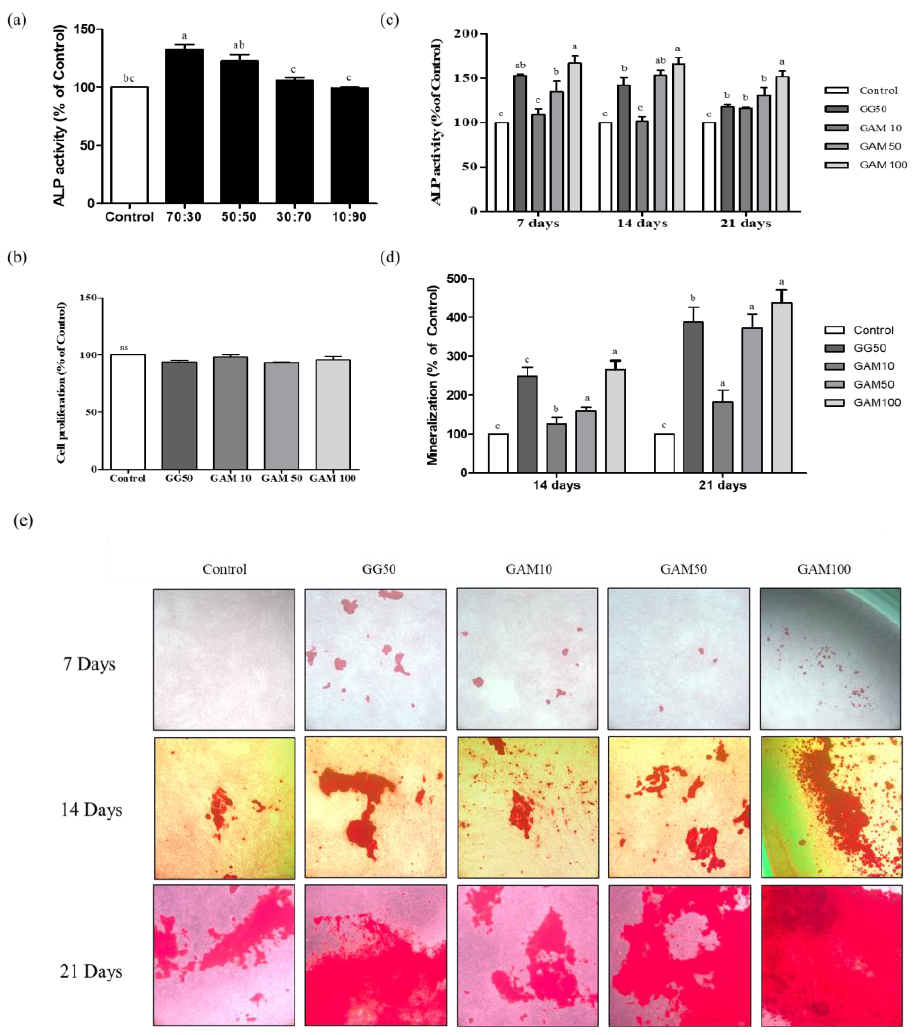
Figure 7. Effects of GAM on ALP activity in MC3T3-E1 cells. ( a ) Effects of GAM on ALP activity at different GG:AG ratios. ( b ) The effects of GAM on MC3T3-E1 cell viability were evaluated using the MTT assay. ( c ) The effects of GAM on ALP activity were evaluated using an ALP activity assay kit. a–c Mean values with different letters differed significantly ( p < 0.05) among groups, as shown by Tukey’s test. ( d ) The effects of GAM on mineralization in MC3T3-E1 cells. ( e ) The effects of GAM on osteoblast differentiation in MC3T3-E1 cells were visualized. The data are the mean ± SD of at least three